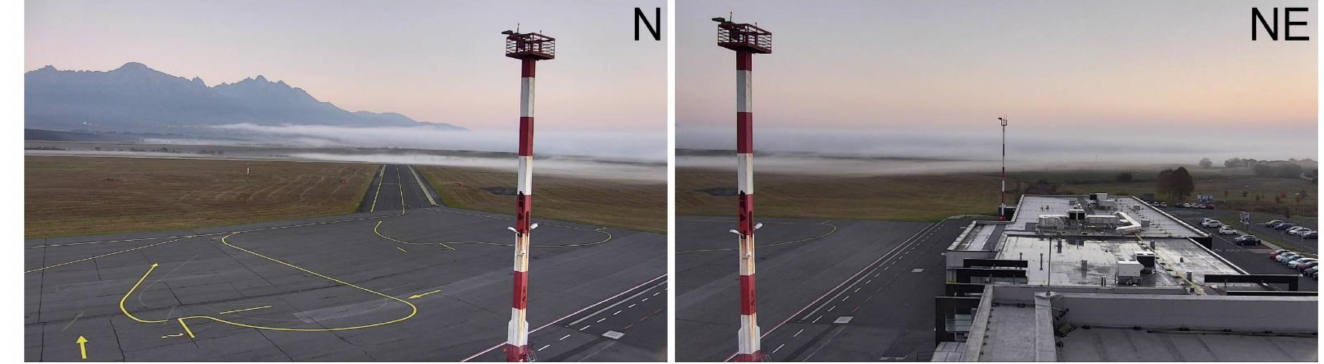
Figure 15. Fog in patches at LZTT, on 10 October 2018, at 04:50 UTC. Table 11. Estimation of visibility using three different approaches at LZTT, on 10 October 2018, at 04:50 UTC. BCFG—Fog in patches. AWOS RO LO 9999 9999 Visibility [m] 4200 1000 to East 1000 to East Phenomenon non BCFG